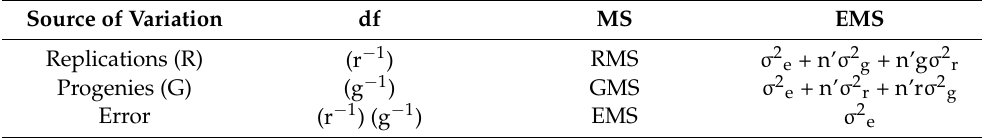
Table 1. Outline of D × P biparental progenies analysis of variance (ANOVA) and expected mean squares for fruit set ratio, inflorescence sex ratio, and its traits. Source of Variation df